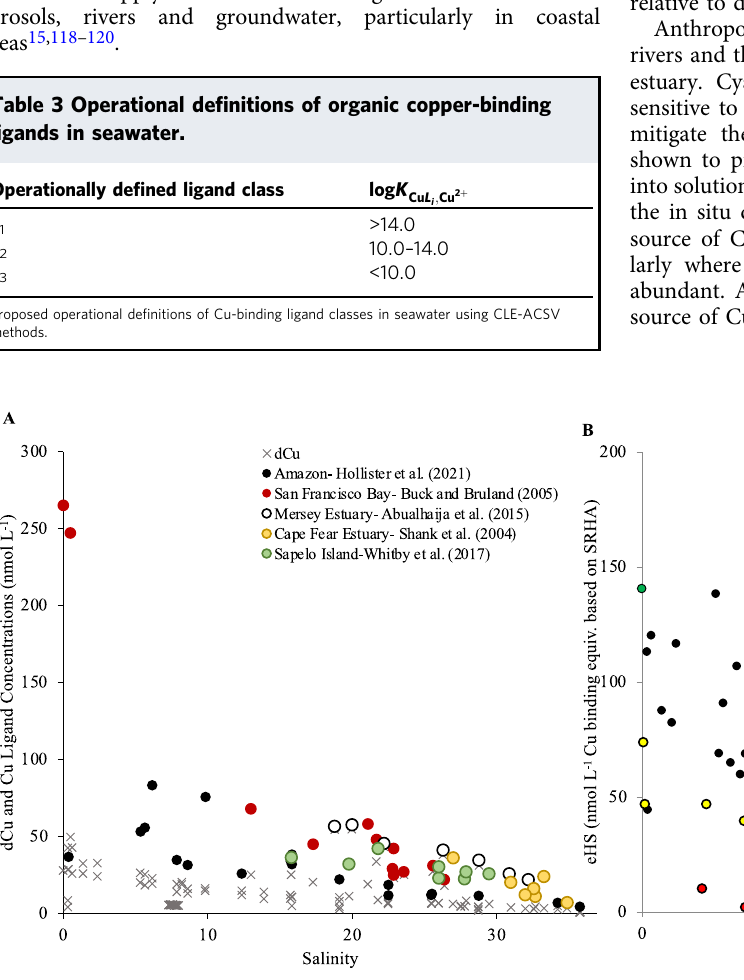
Fig. 1 Dissolved copper and organic ligands in estuarine systems. Data from select studies showing typical A dissolved Cu concentrations ( x ) and organic Cu-binding ligand concentrations (circles), and along the river to seawater continuum. B Concentrations of electroactive humic substances expressed in terms of their potential Cu-binding equivalent concentration, based on values calculated for SRHA in Whitby et al. 43 . Amazon, Mersey, and Sapelo data use the CuHS technique 43 ; San Francisco Bay, Fundao Dam, and Irish Sea use the FeHS technique 243 – 245 , while Loire Estuary uses the MoHS technique 92 ; different methods have been shown to give comparable eHS concentrations 35,246 .